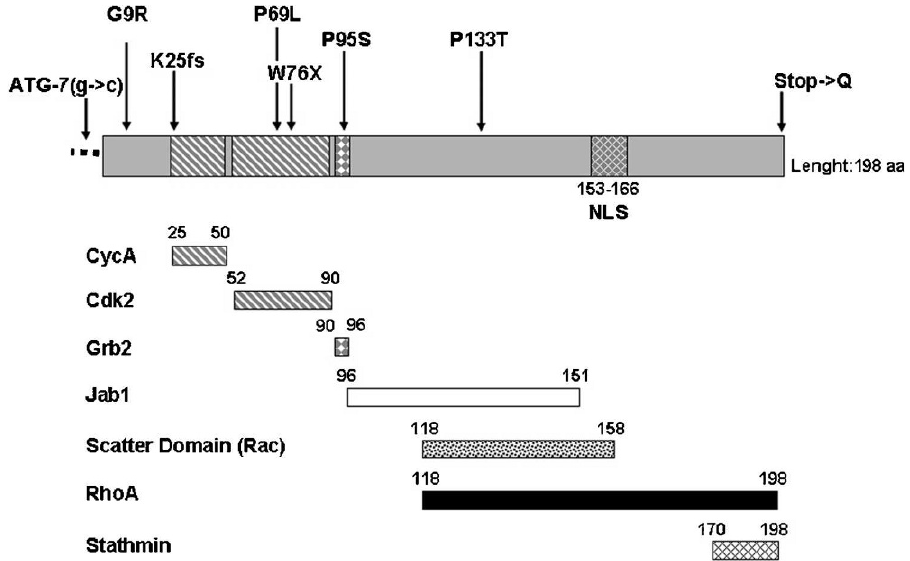
Figure 2 - Schematic structure of the p27 protein and position of the germline mutations identified. The regions mediating the binding of p27 to its major interacting partners, which are reported below the protein, are indicated. The germline mutations so far identified in MEN4 patients are indicated above the protein sequence. NLS = nuclear localization signal.